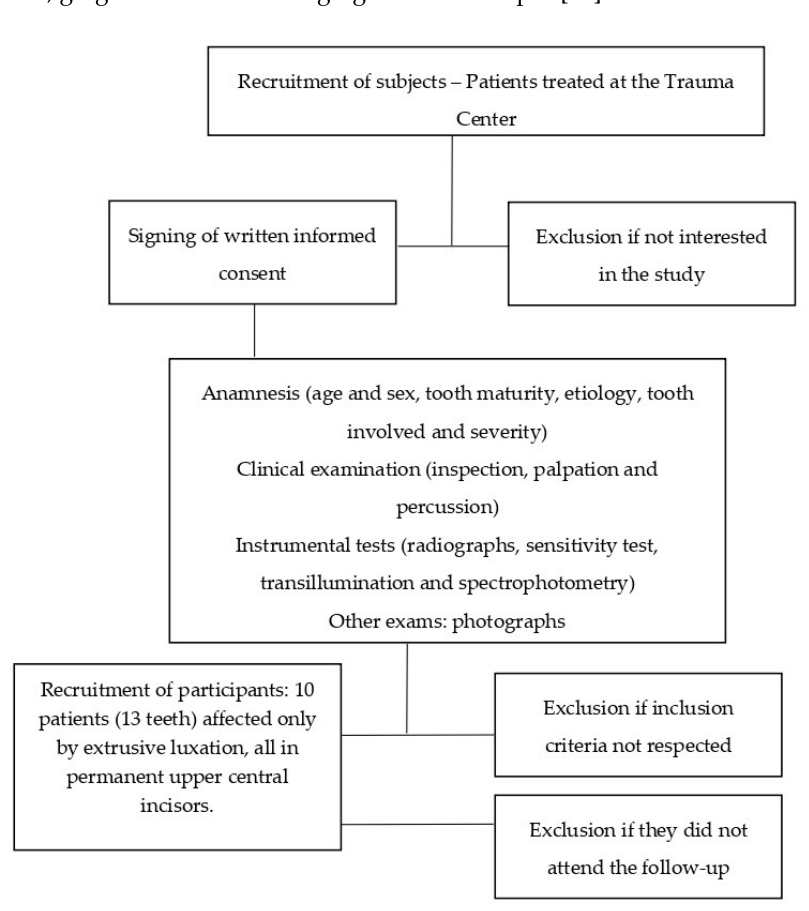
Figure 1. The recruitment process that led to the final sample.